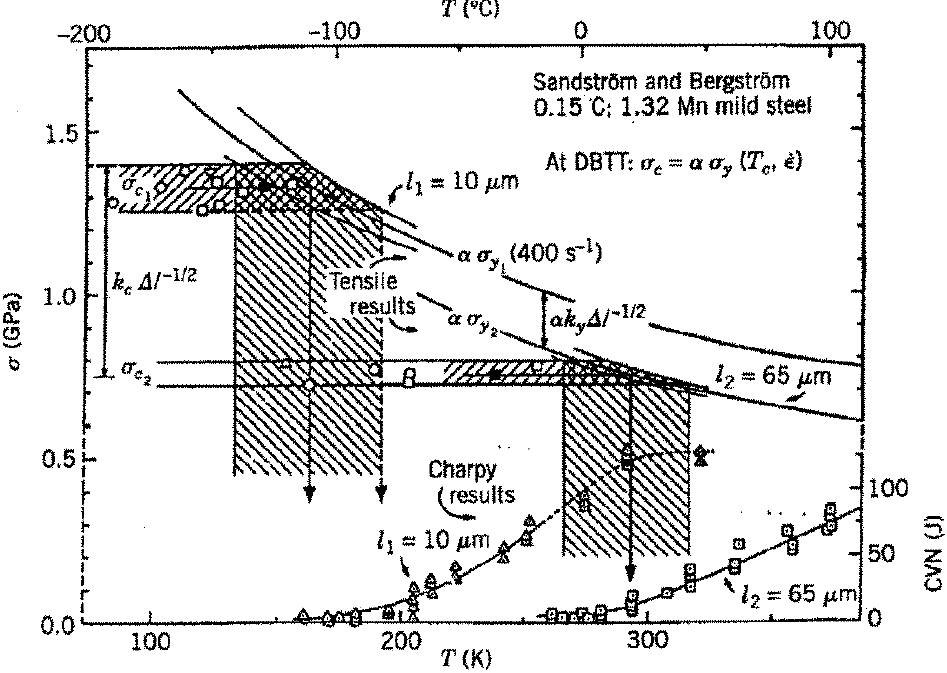
Figure 5. The ductile-to-brittle transition temperatures for two steel materials with different grain sizes of 65 and 10 µ m as determined in tensile tests and via Charpy v-notch (CVN) impact tests [13].